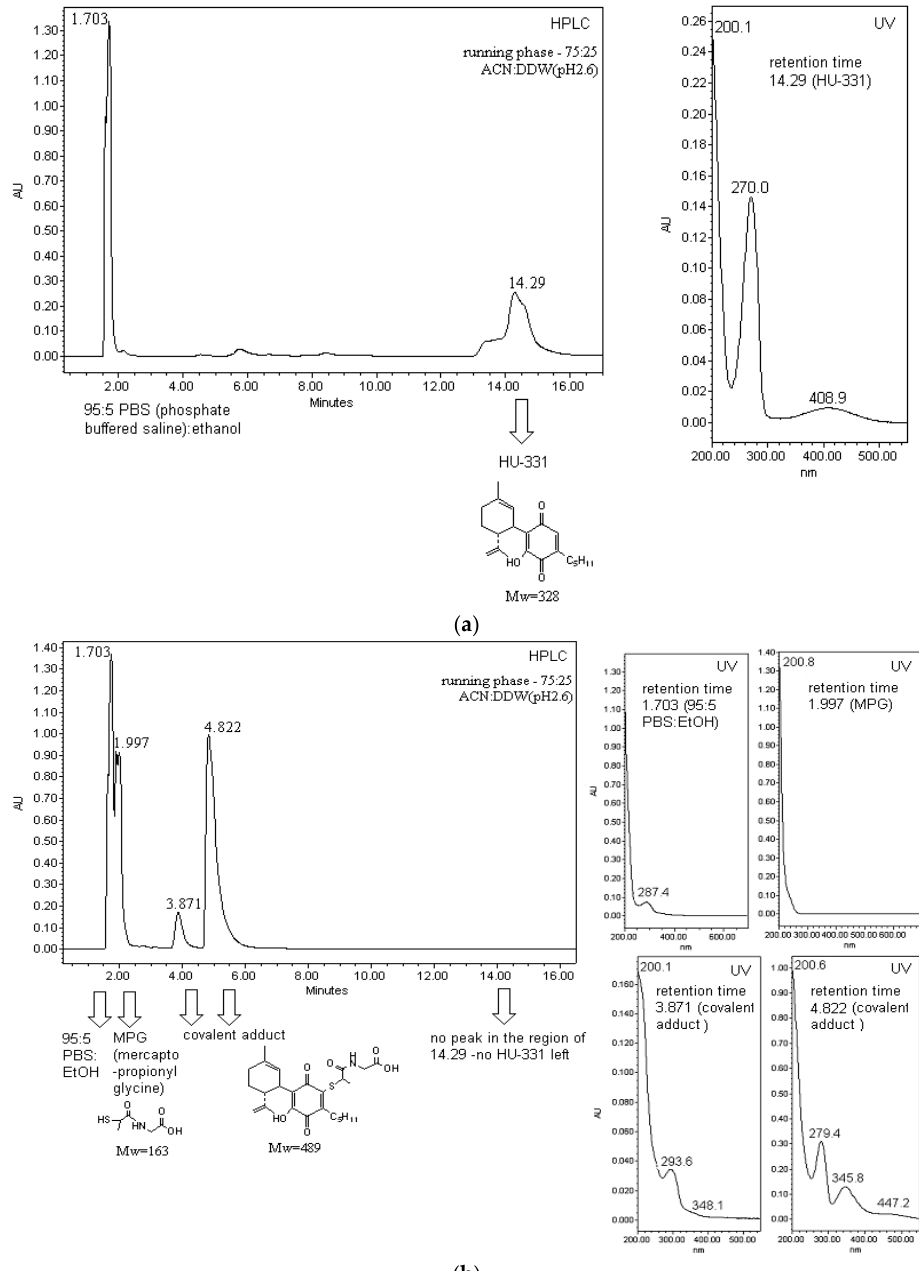
Figure 3. HPLC analysis of MPG binding to HU-331: ( a ) HPLC-UV of HU-331; ( b ) HPLC-UV of HU-331 after the addition of